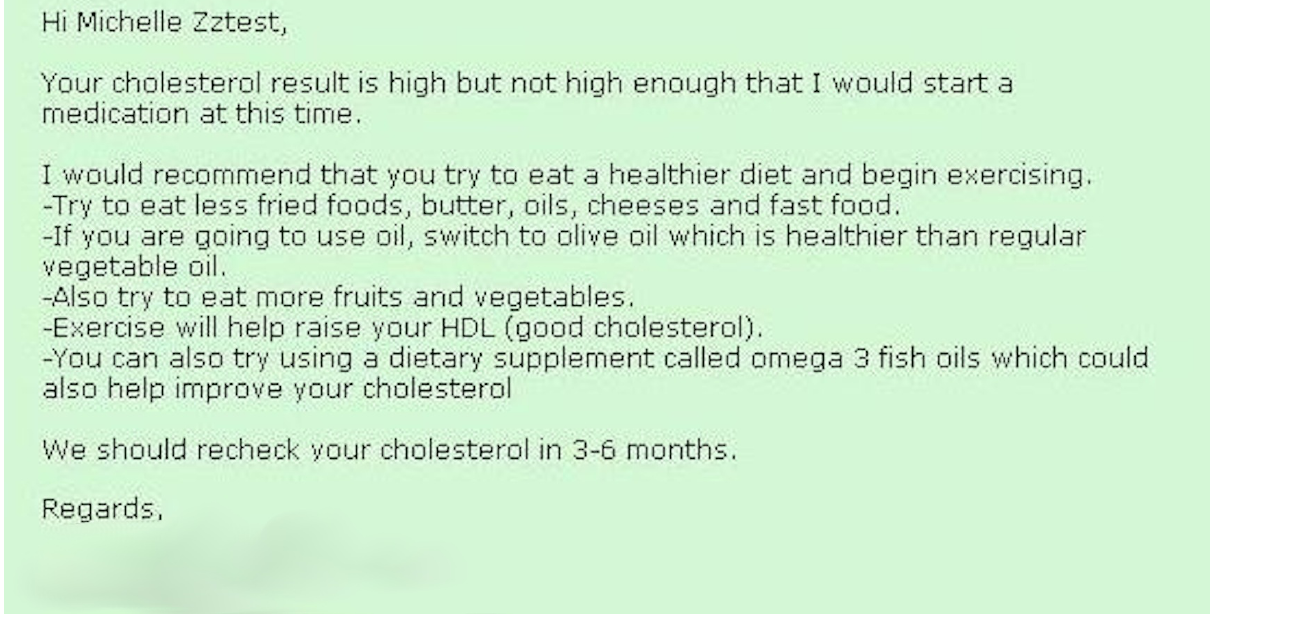
Figure 3. Provider's note accompanying cholesterol test